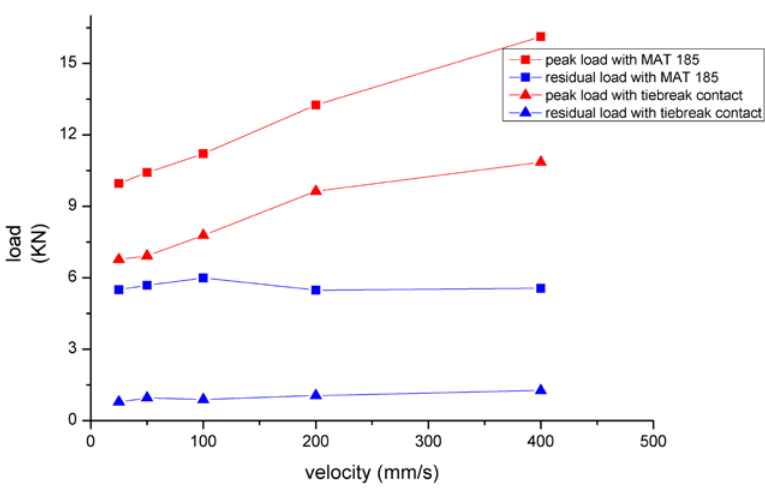
Figure 7. Comparison of peak load and residual load with MAT 185 and tiebreak contact.